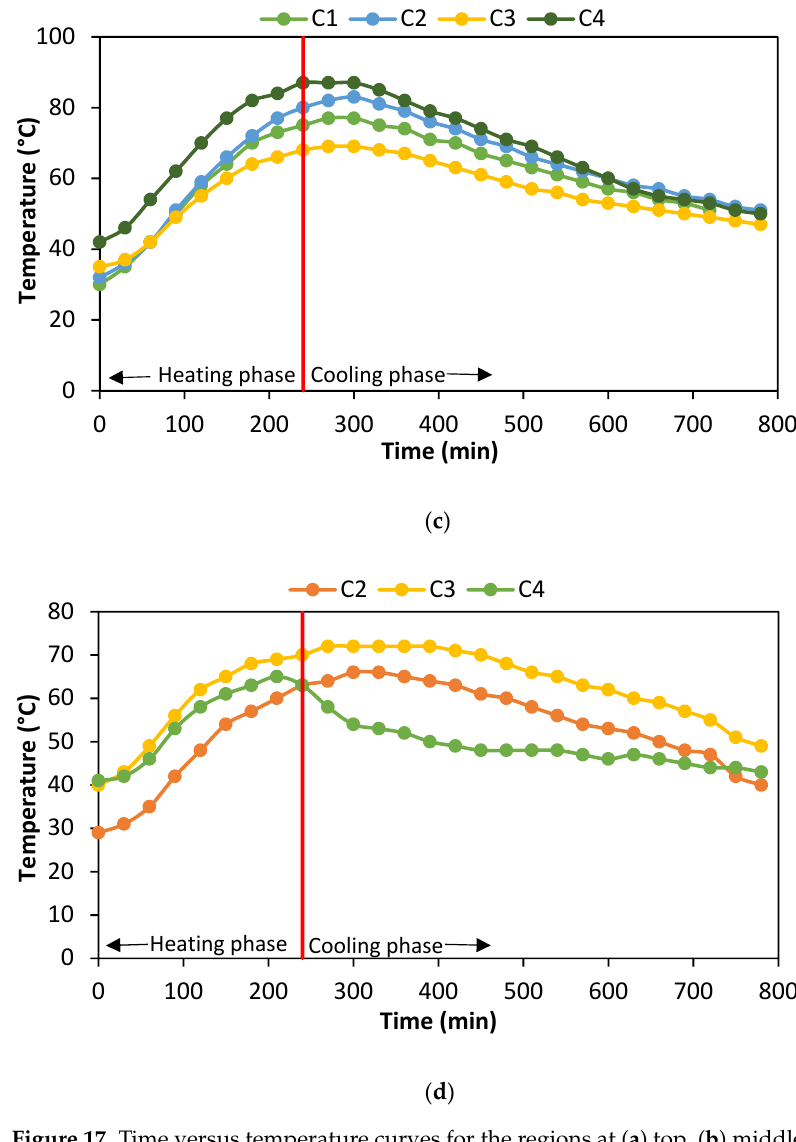
Figure 17. Time versus temperature curves for the regions at ( a ) top, ( b ) middle, ( c ) and bottom ( d ) mimicked cone.